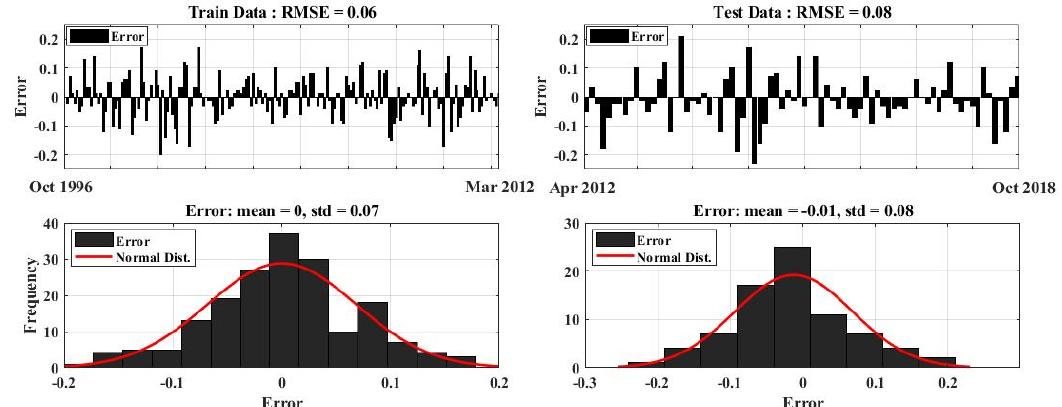
Figure 10. Distribution of the GWL-random errors of the wavelet-ANFIS model.